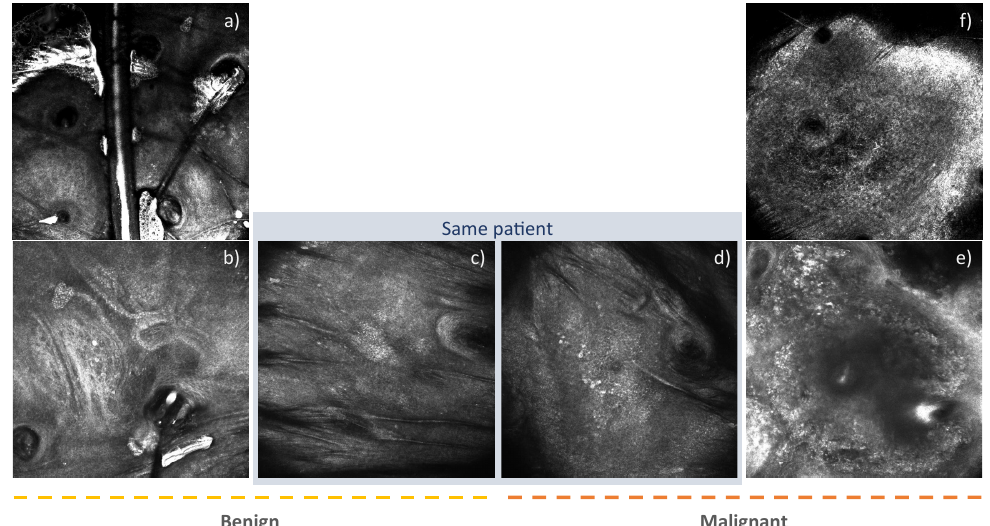
Figure 6. Examples of RCM images that mislead the classifier with the highest F 1 score (Inception-ResNet + SVM − Linear). On the left part ( a – c ), RCM images belonging to the benign label and classified as malignant. On the right part ( d – f ), RCM images belonging to the malignant label and classified as benign. In the center of the figure ( c , d ), two RCM images of the same patient belonging to benign and malignant